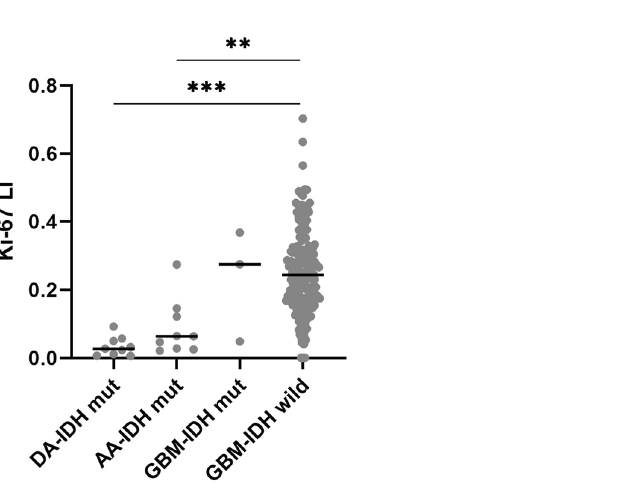
Figure 2. Box-plots showing the Ki-67 LI in different glioma subgroups. The horizontal line is the median.